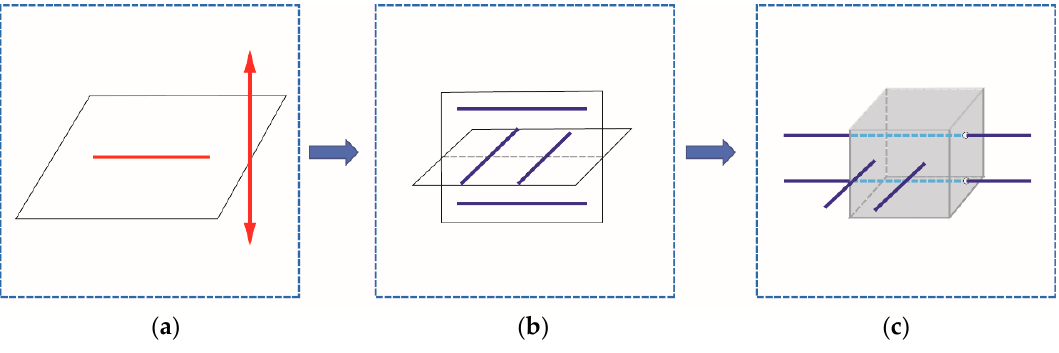
Figure 9. Conceptual design of 2DOFs TMDs: ( a ) freedom space of 2DOFs TMD; ( b ) constraint space of 2DOFs TMD; ( c ) physical model of 2DOFs TMD.